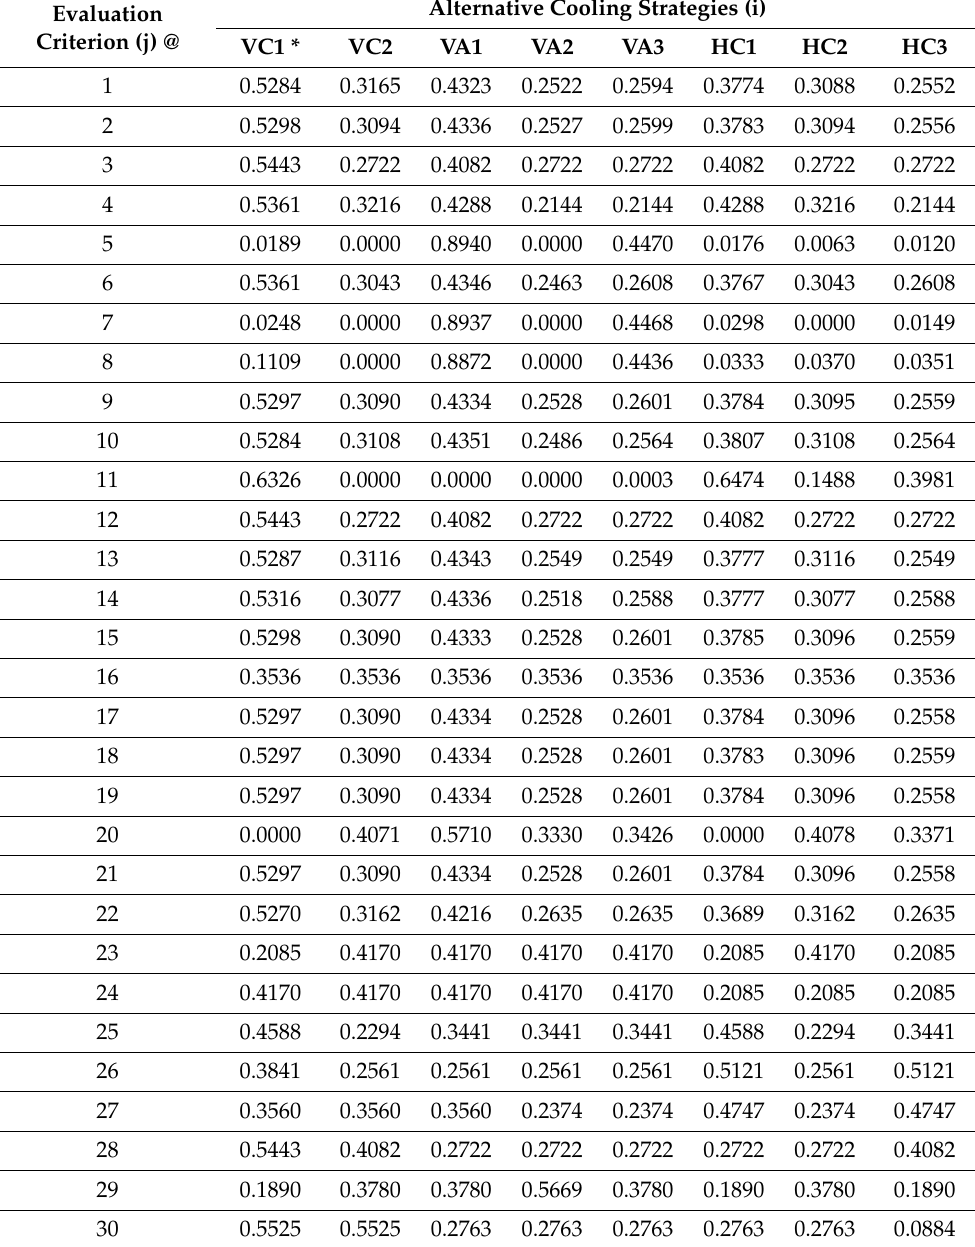
for cooling maritime arid climatic ij